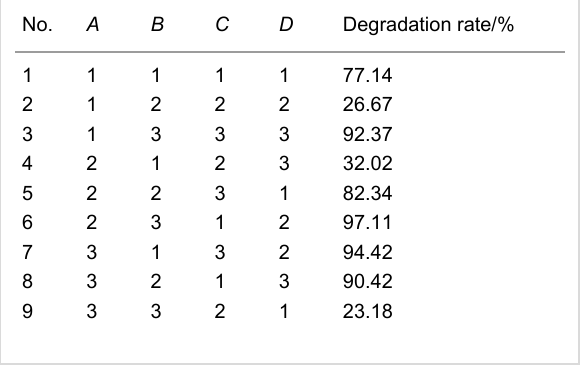
Table 1: Design and results of the orthogonal experiments. No.